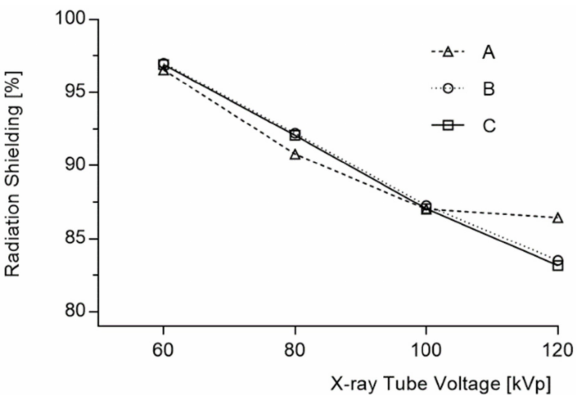
Figure 6. Change in shielding efficiency based on particle size (A: nanoparticle, B: microparticle, C: mixture of microparticles and